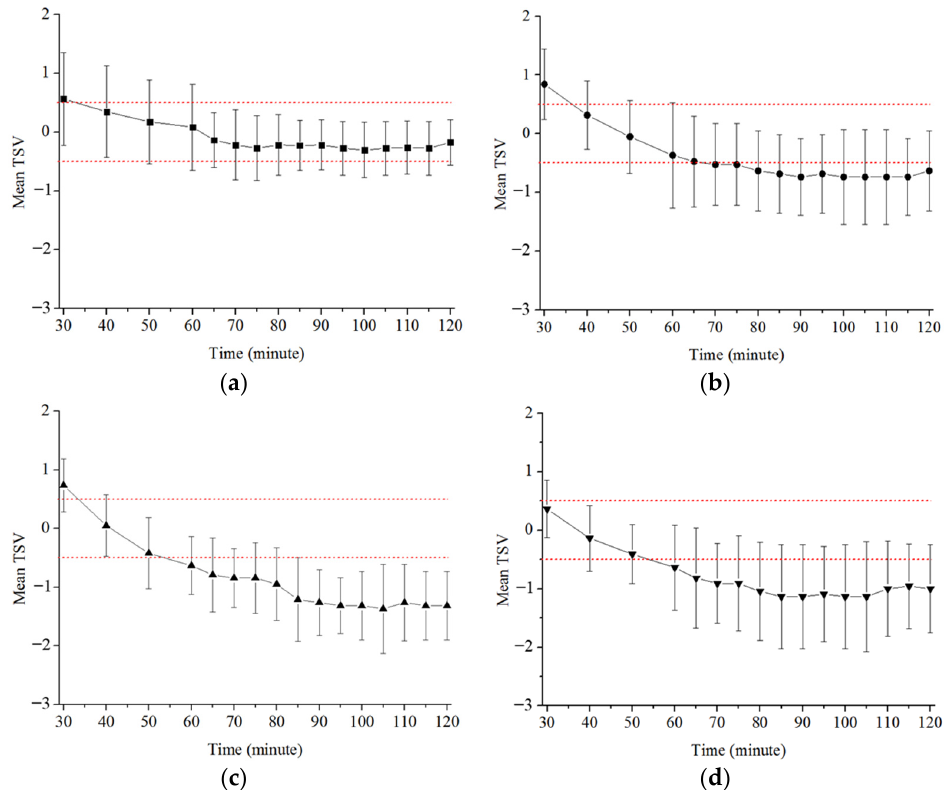
Figure 7. Mean thermal sensation vote during four experimental scenarios (mean ± SD). ( a ) Sce- nario A: 29 → 27 °C. ( b ) Scenario B: 29 → 25 °C. ( c ) Scenario C: 29 → 23 °C. ( d ) Scenario D: 27 → 23 °C.